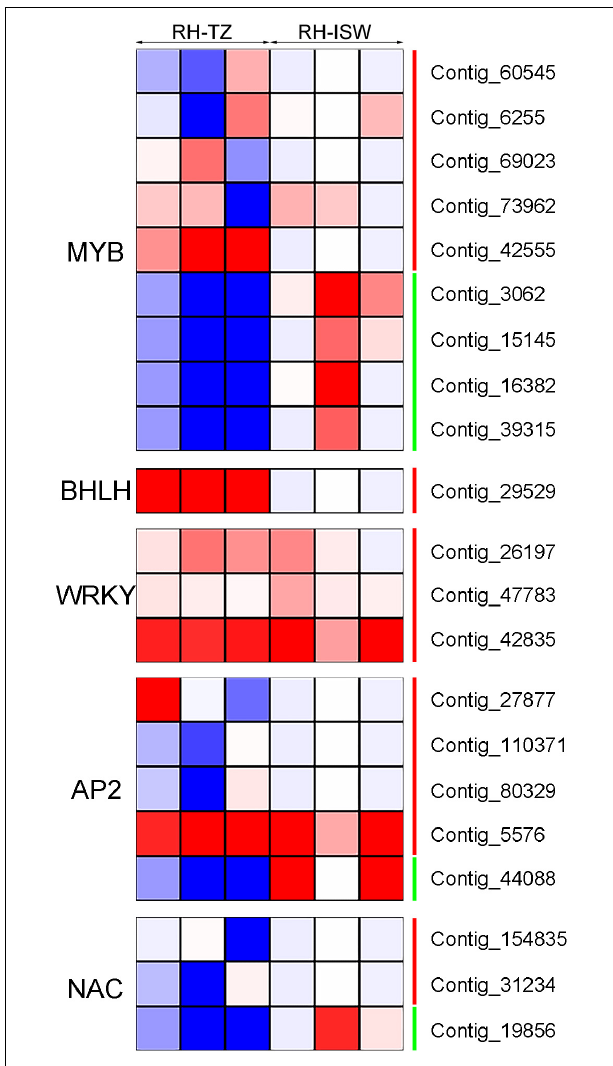
FIGURE 8 | Differentially expressed transcription factors in RH-TZ vs. RH-ISW. The green line on the right side of the heatmap represented downregulation while the red line represented upregulation. Differentially expressed transcription factors were identified by p < 0.05 and absolute value of log2 ratio ≥